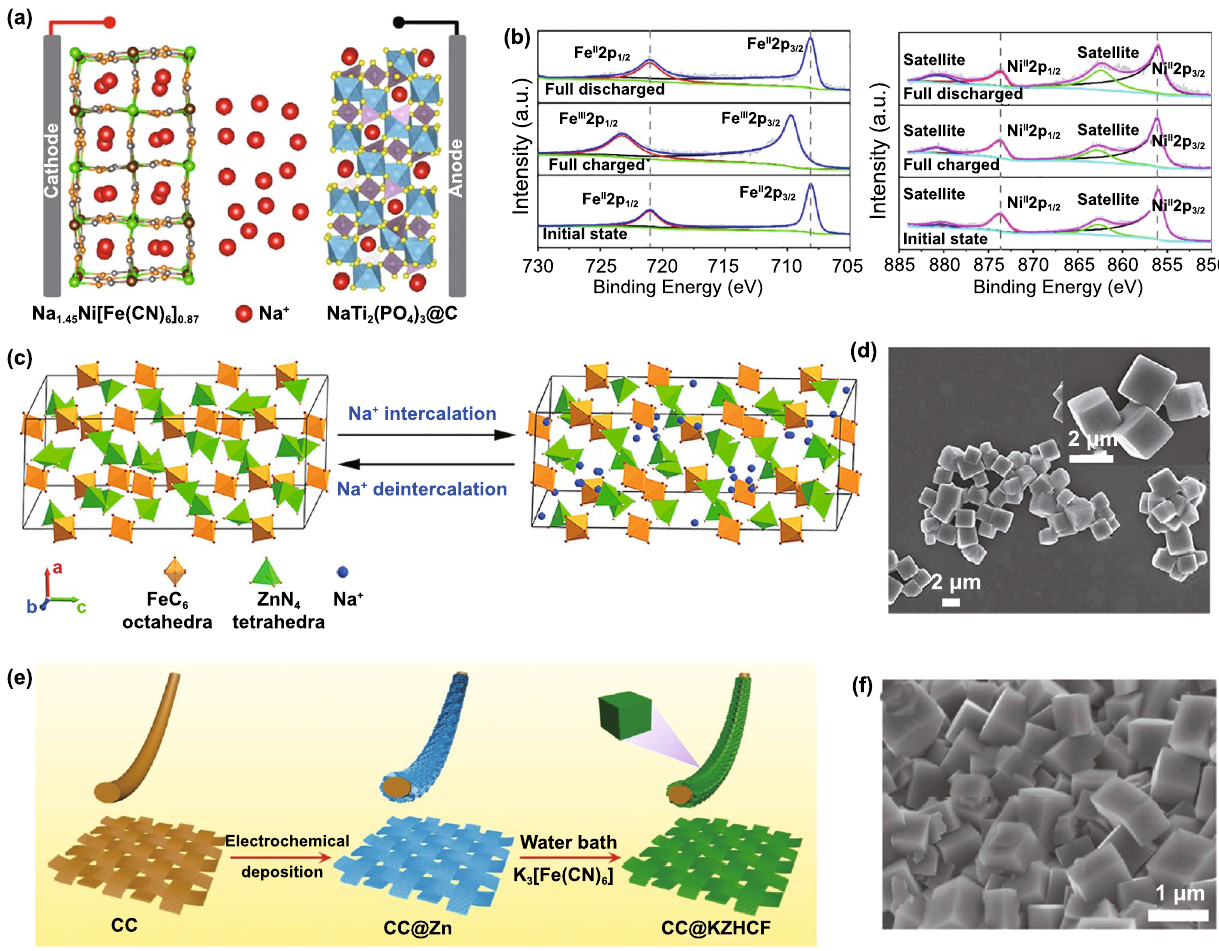
Fig. 6 a Schematic illustration of Na 1.45 Ni[Fe(CN) 6 ] 0.87 ·3.02H 2 O/NaTi 2 (PO 4 ) 3 full cell. b Ex situ XPS of Fe 2p (left) and Ni 2p (right) spec- tra. Reproduced with permission from Ref. [95]. Copyright 2020, Elsevier. c Schematic illustration of sodium-ion intercalation mechanism in Zn 3 [Fe(CN) 6 ] 2 . d SEM images of the pristine Zn 3 [Fe(CN) 6 ] 2 . Reproduced with permission from Ref. [100]. Copyright 2018, Elsevier. e Sche- matic fabrication process of